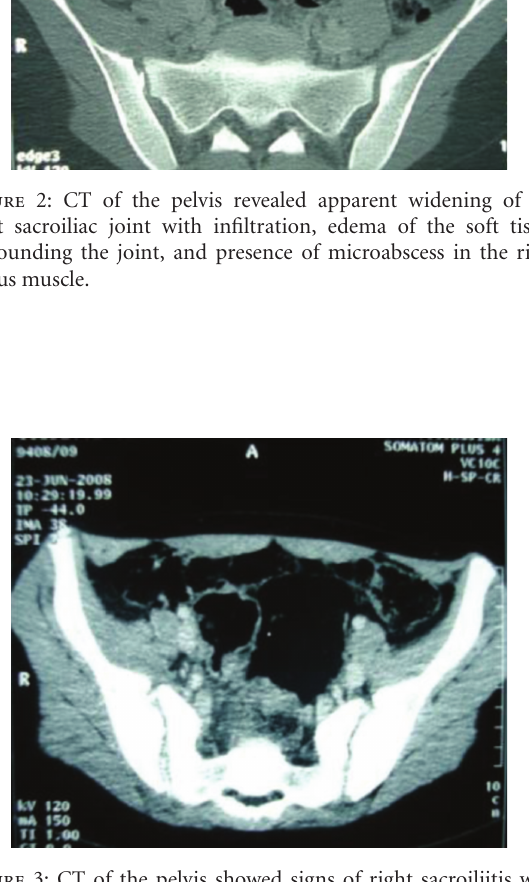
Figure 3: CT of the pelvis showed signs of right sacroiliitis with infiltration and microabscess of the soft tissue, surrounding the joint with erosions of the subchondral iliac